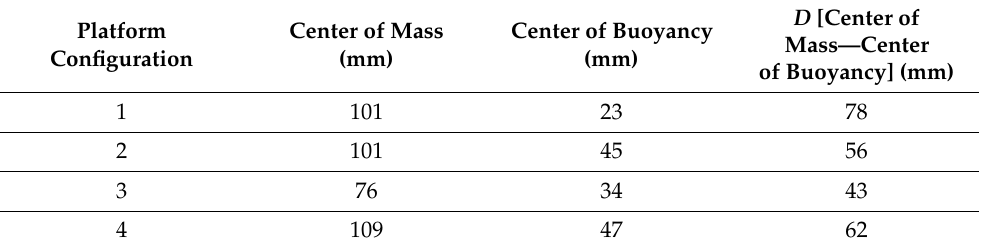
Table 2. Comparing the Center of Mass and Center of Buoyancy of each Configurations. All measurements are taken from the bottom of the platform legs. Platform